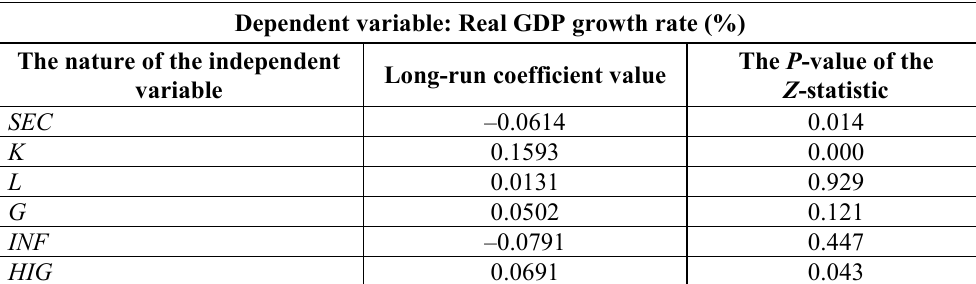
Table 5. Long-Run Effect of Determinants of Economic Growth Dependent variable: Real GDP growth rate